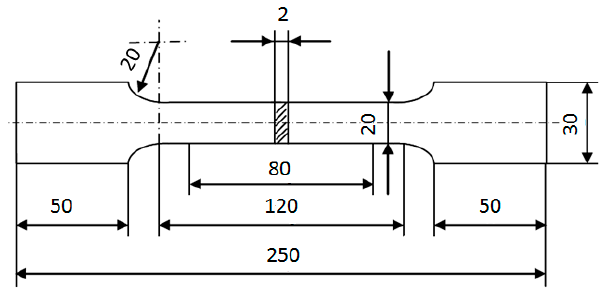
Figure 2. Geometry of the tensile test specimen (dimensions are given in mm).